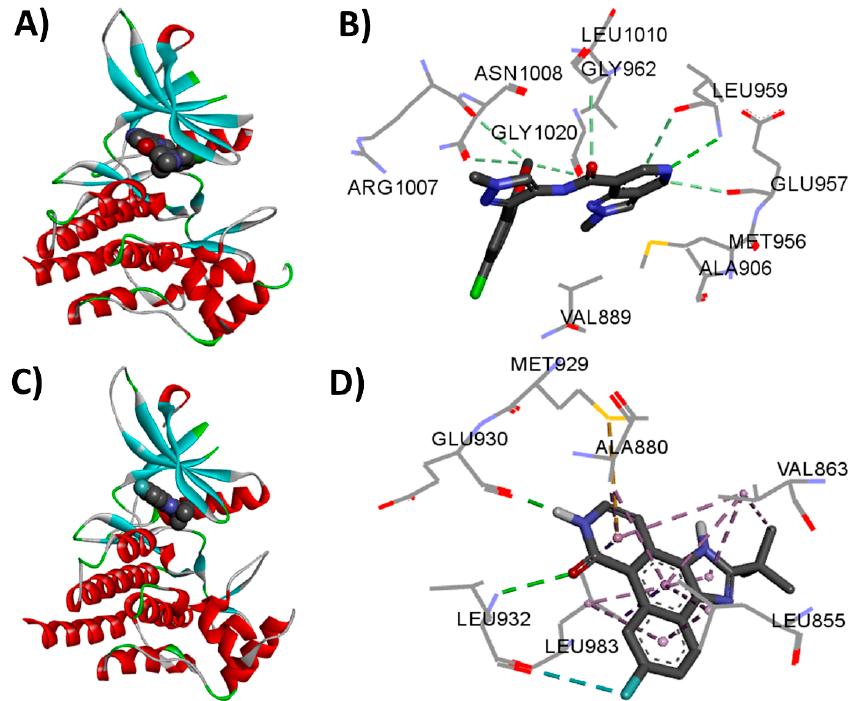
Figure 8. JAK1 (pdb: 6N7A) and JAK2 (pdb: 2B7A) kinases bound to small-molecule inhibitors: ( A ) 3D representation of JAK1 bound to KEV (shown as CPK); ( B ) 3D binding mode of KEV into JAK1 showing the hydrogen bond interactions; ( C ) 3D representation of JAK2 bound to IZA (shown as CPK); ( D ) 3D binding mode of IZA into JAK2, hydrogen bonds are shown as green-dotted lines, this figure was generated using Discovery Studio Visualizer (V16.1.0.15350).